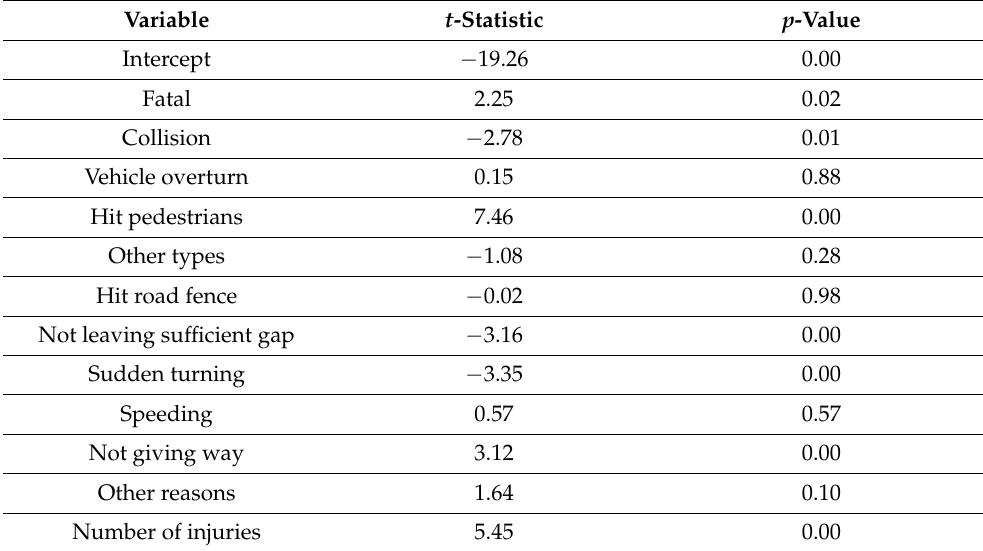
Table 5. The t -statistics and p -values for the coefficients of the utility Equation (1). Variable